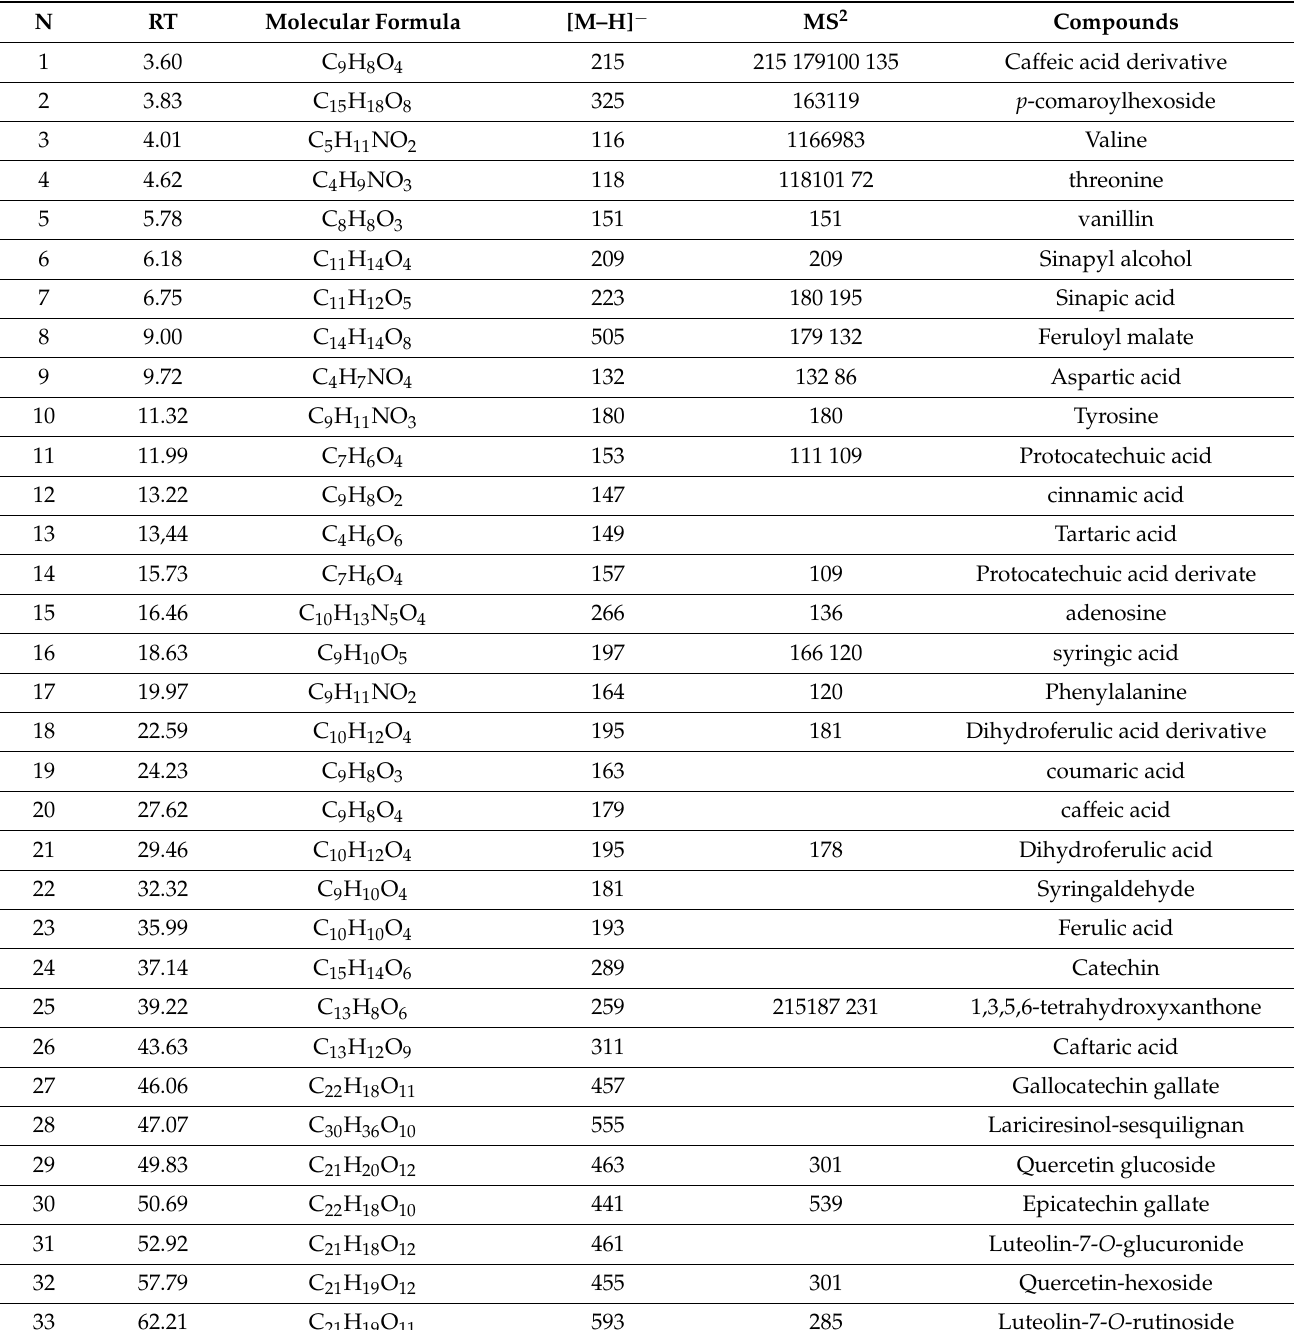
Table 2. Identification of C. moschata polyphenols by